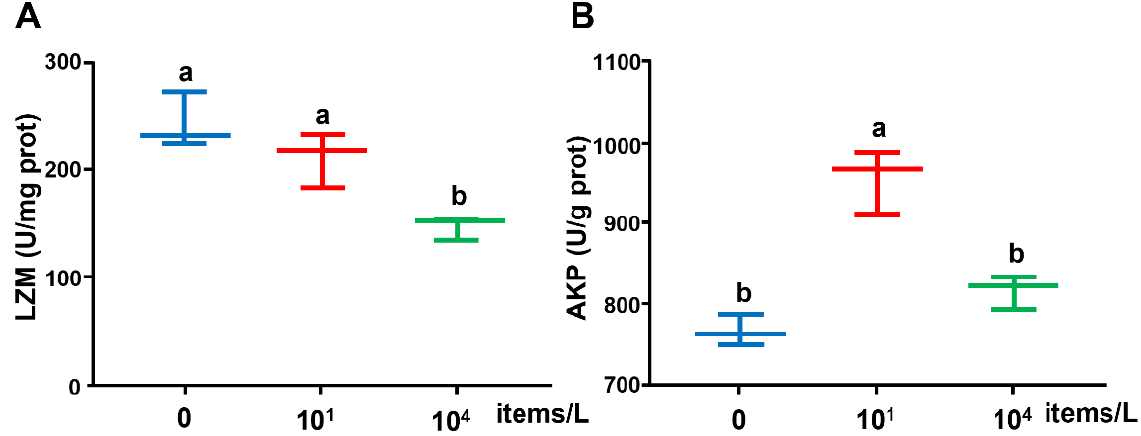
Figure 1. ( A ) CH Tr, ( B ) TRS, ( C ) LPS, and ( D ) AMS activities in the liver of medaka exposed to NPs (0, 10, 10 4 items/L) for three months ( n = 8). Different lowercase letters indicate significant differences among treatments ( p < 0.05).